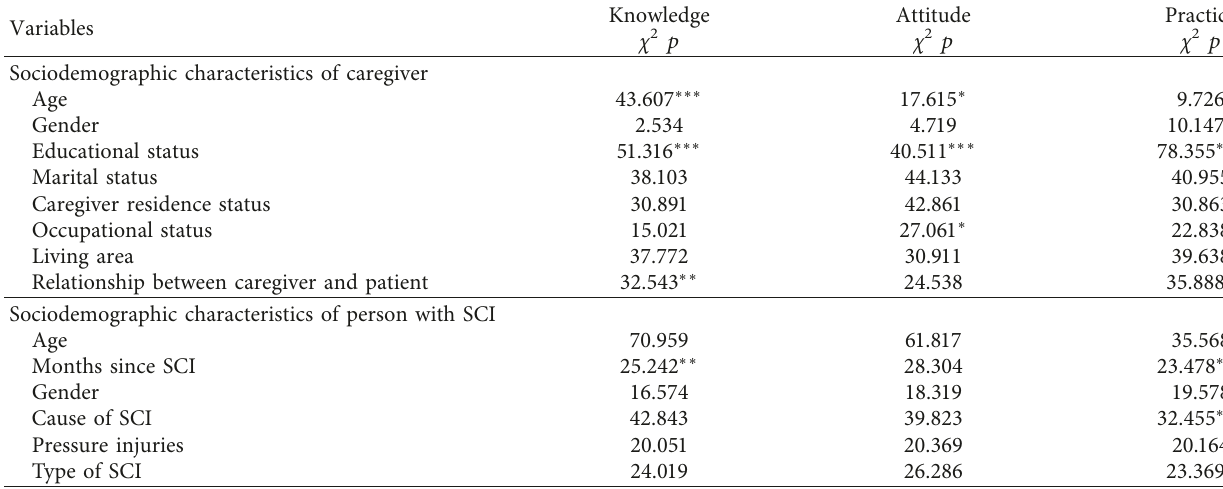
Table 4: The relationship between caregivers’ KAP and sociodemographic characteristics of the caregivers and individuals with SCI in terms of PI prevention and care.